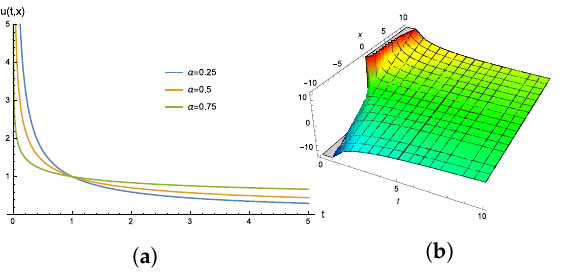
Figure 1. Behaviors of ( a ) solution (48) and ( b ) solution (56) with α =